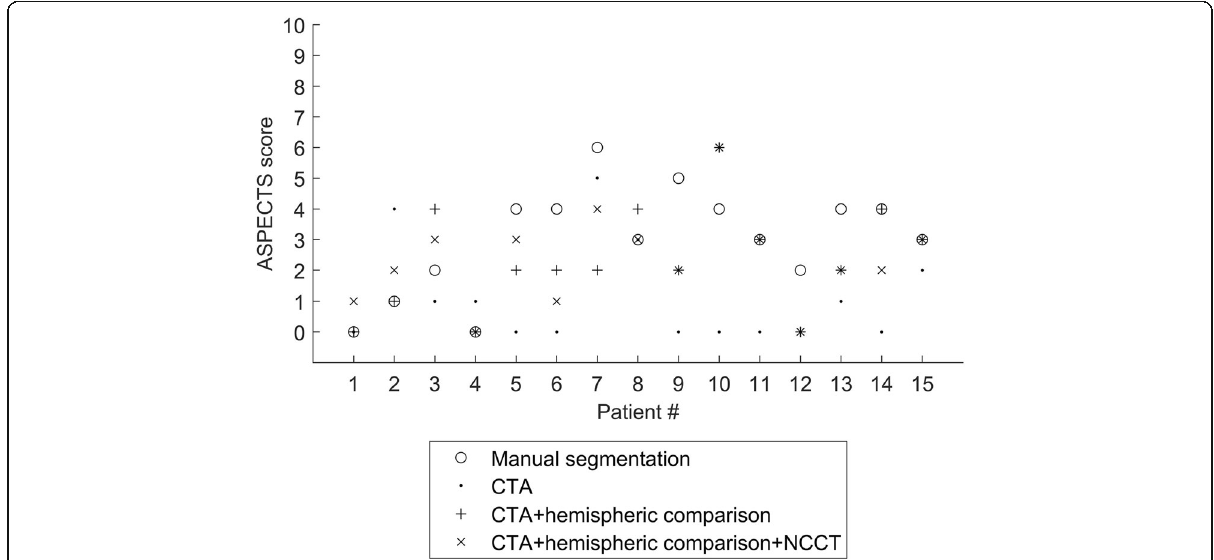
Fig. 6 ASPECTS points of the manual segmentation and three CNN outputs for the group A patients (test data). All the scores are calculated from the CTA-SI; if a single positive voxel belongs to the specified region, it is marked as stroke positive. The number of positive regions is subtracted from 10 to get the ASPECTS points and the minimum (worst case) between the hemispheres is the reported